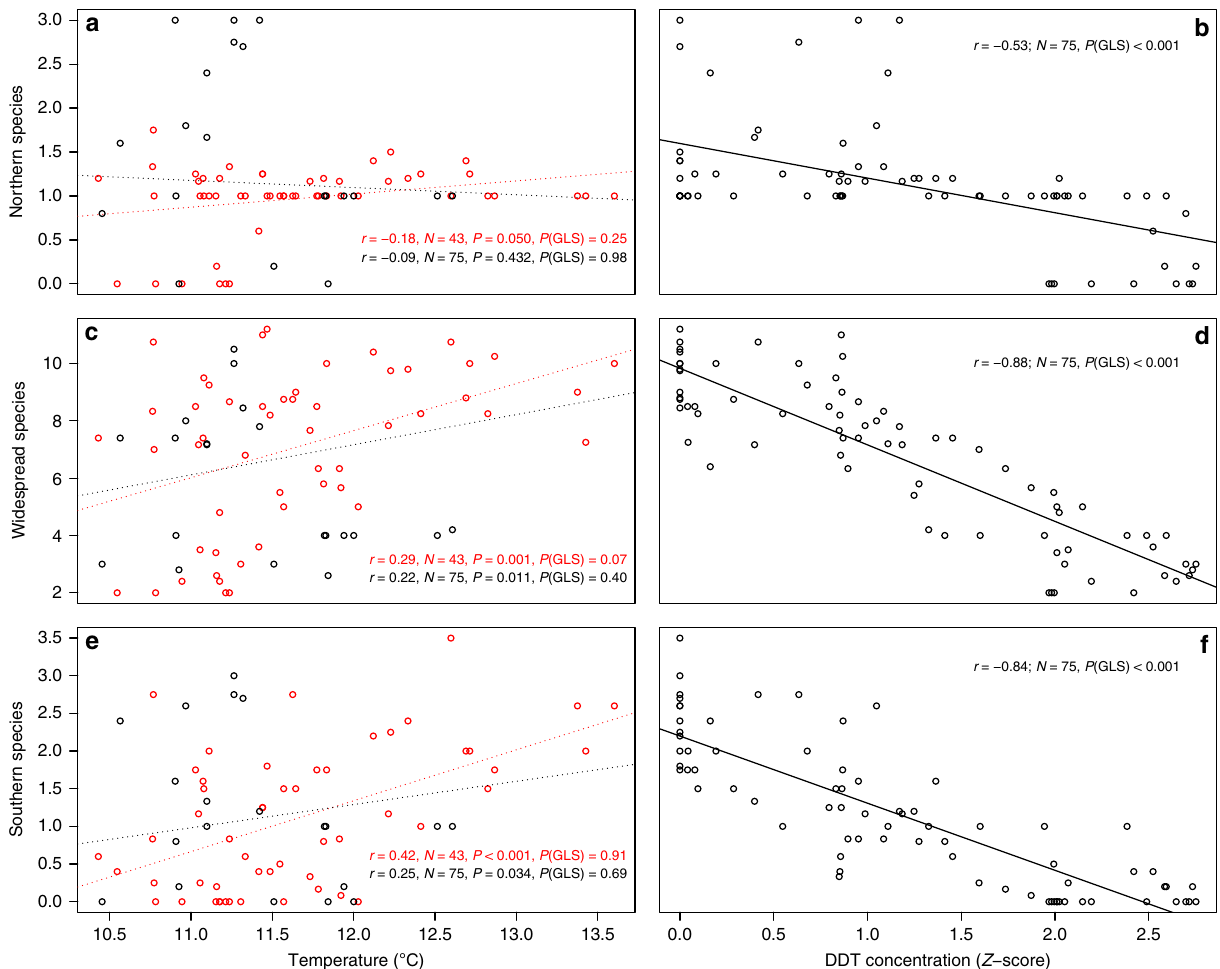
Figure 5 | Relationships between mosquito species richness and temperature or DDT. The average number of mosquito species per trap are plotted against the yearly average temperature (in degrees Celsius; points in black are 1938–1959, before and during DDTuse; points in red are 1960–2012 when DDT concentrations in the environment were declining) for Northern ( a ), Widespread ( c ) and Southern ( e ) mosquito species and plotted against DDT concentration ( b , d , f , Z -score) in Suffolk County, New York. For the left panels, simple Pearson product-moment correlation coefficients, sample size, and P -values are given, followed by the P -value from GLS analyses that accounts for the residual temporal autocorrelation (‘ P (GLS)’). Equations in red show analyses for just the red points (1960–2012), whereas equations in black show analyses for the full dataset 1938–2012. Dashed lines show the best fit lines but none were significant in the GLS analyses. In the right panels only the P -values from the GLS are shown (all Pearson product-moment correlation P -values for DDT were o 0.001 for the full datasets and for the period 1960–2012).